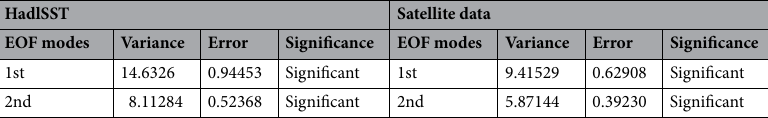
computed at each grid point after removing the contributions of the first EOF mode (henceforth, reconstructed SST anomaly). Further, point correlation is performed for the time series at the loading centers (Fig. 1a) with the reconstructed SST anomaly (Fig. 2a–h corresponding respectively to points (i) to (viii) of Fig. 1a). Only correla- tion values above 99% significance are shown in the figure. The results suggest a clear existence of wave number-4 pattern across the globe and sign of correlation changes with polarity except for the pole south of Australia (viii in Fig. 1), which apparently is not very much synchronized with the anomalies on both sides of South America (Fig. 2h). But, the south of Australia pole is well correlated with polarities in the Indian Ocean and the Pacific. After confirming the physical presence of W4 mode in the SST anomalies, we checked its possible relationship with other climatic modes. The W4 lagged cross-correlations with other climate indices are listed in Table 2. SAM and IOD correlations are insignificant with IW4 at 90% confidence interval, whereas ONI, IOSD, SASD show